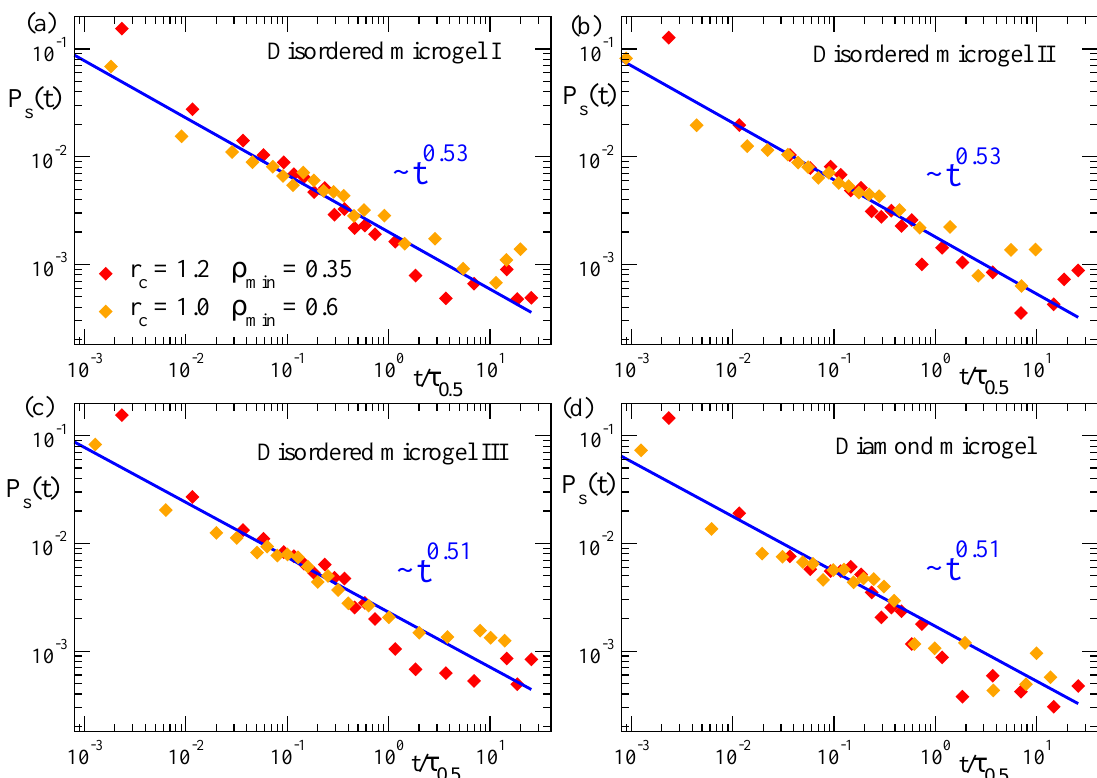
Figure 8. Domain self-correlation function P s ( t ) for three disordered microgels of small ( a ), middle ( b ) and large asphericity ( c ), and for the diamond-like microgel ( d ), during the collapse at φ = 1.2. The results displayed correspond to the couples of parameters ( r c = 1.0, ρ min = 0.6) and ( r c = 1.2, ρ min = 0.35) defining the density field. In each dataset the time has been rescaled by τ 0.5 , with τ 0.5 defined as in Figure 3. Lines fit to power-law dependence. Exponents are